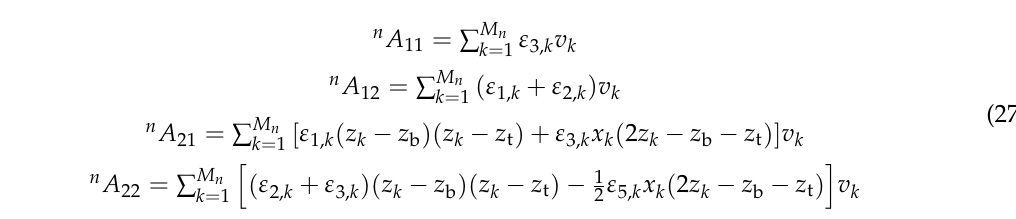
Figure 5. 3D displacement measurement of a double-layer phantom. ( a ) OCT images: ( a-i ) a 3D OCT image with the ROI marked by a blue cube; ( a-ii ) a 2D OCT image with the ROI marked by a blue rectangle; ( b – d ) 3D displacements in the x , y and z directions respectively. Two displacement maps on the right side of each 3D image are the cross-sections along the dashed lines on ( b – d ). The full-field strain ε and virtual strains ε * ( i ) were input to Equation (17). The two coefficient matrixes n A were